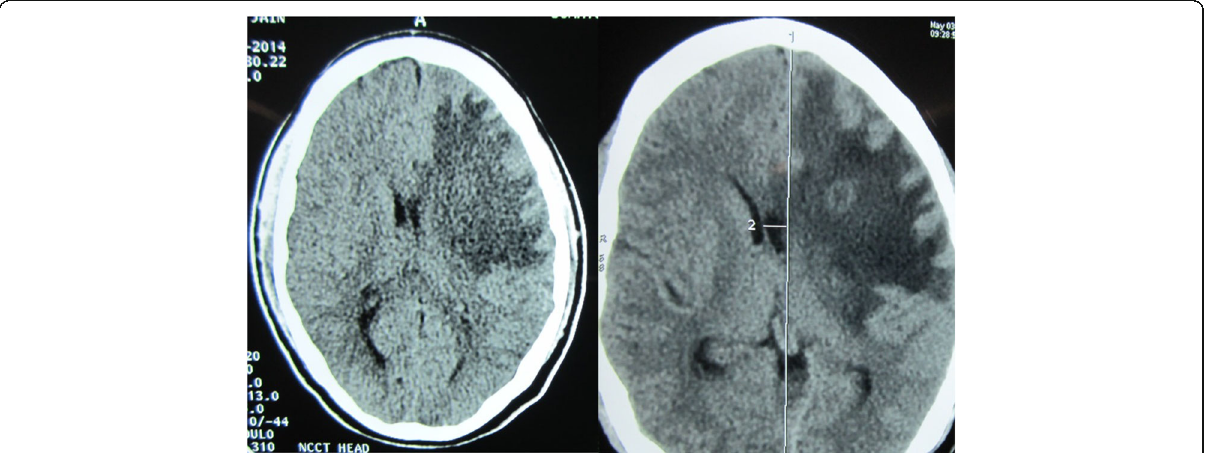
Fig. 1 Computed tomography showing left diffuse oedema in the left frontal region. Right Contrast CT showing thick small ring with central hypodensity surrounded by brain oedema with effacement of frontal